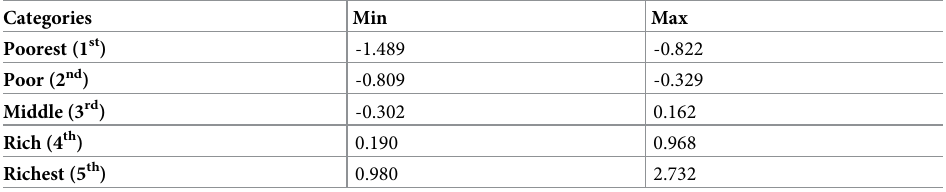
Table 2. SES score categories.